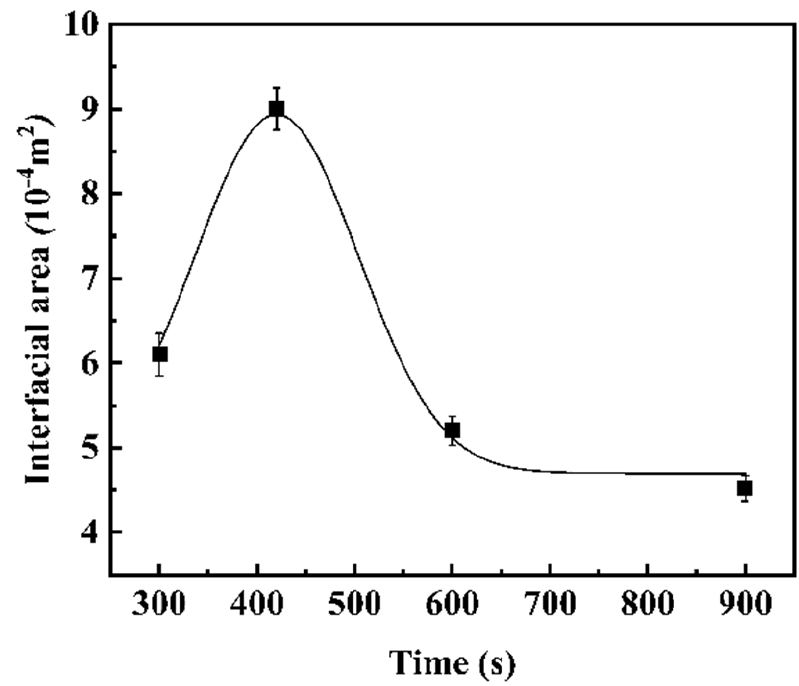
Figure 10. Change of interfacial area during the reaction of Fe-5Al alloy with low SiO 2 flux.